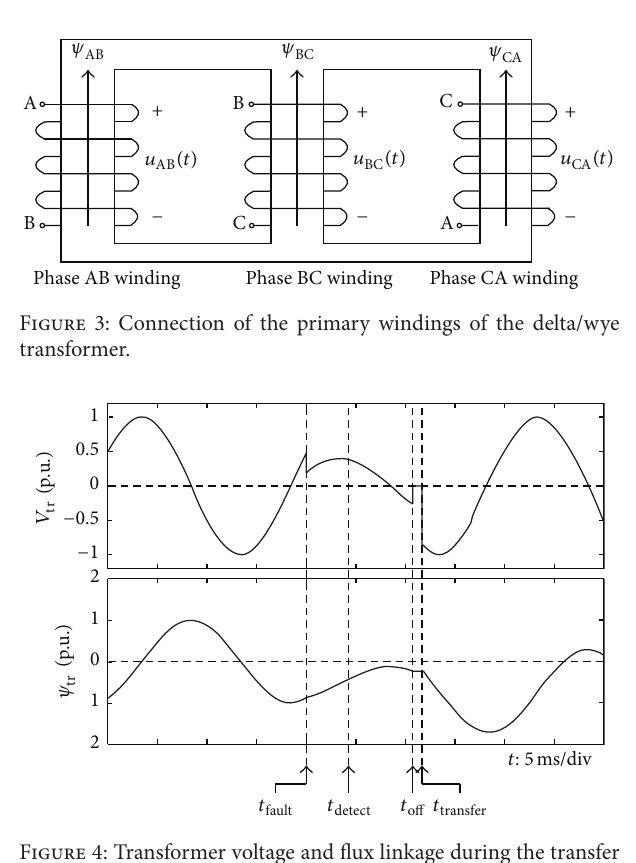
Figure 4: Transformer voltage and flux linkage during the transfer process.